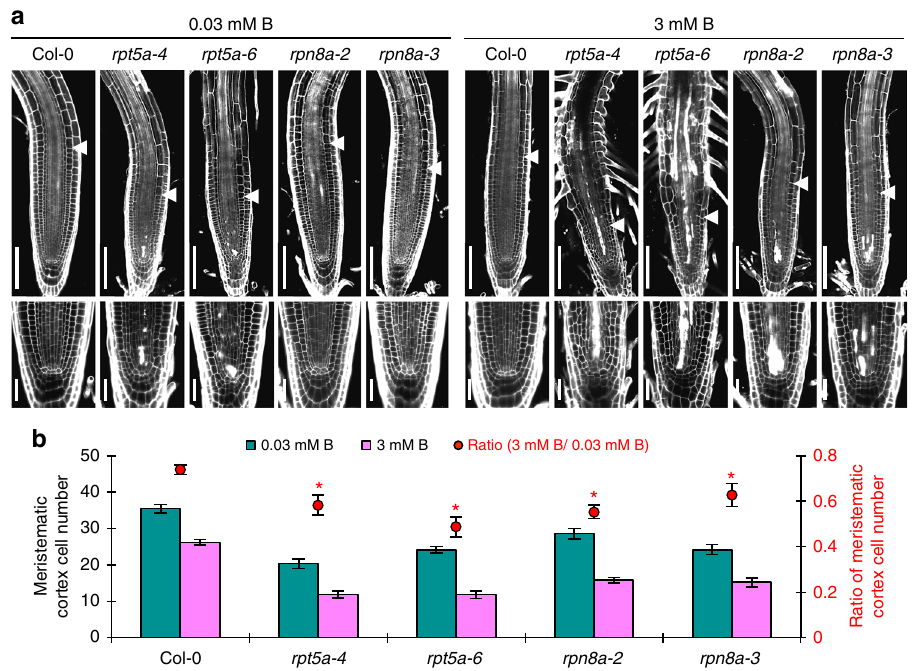
Fig. 3 Both RPT5a and RPN8a are required for RAM maintenance under high-B conditions. a Representative images of Col-0, rpt5a mutant, and rpn8a mutant root morphology under normal- and high-B conditions. Arrowheads indicate the border between the meristem and elongating region. The bottom panels are magni fi ed images to indicate the area of cell death and cell alignments around the stem cell niche. Scale bars, 50 µ m. b Effect of high-B stress on the number of cortex cells in the RAM of Col-0, rpt5a , and rpn8a . Red circles represent the ratio relative to the value under 0.03 mM B conditions ( n = 10 – 14, average ± s.e.m.; * P < 0.05, compared with Col-0, Student ’ s t